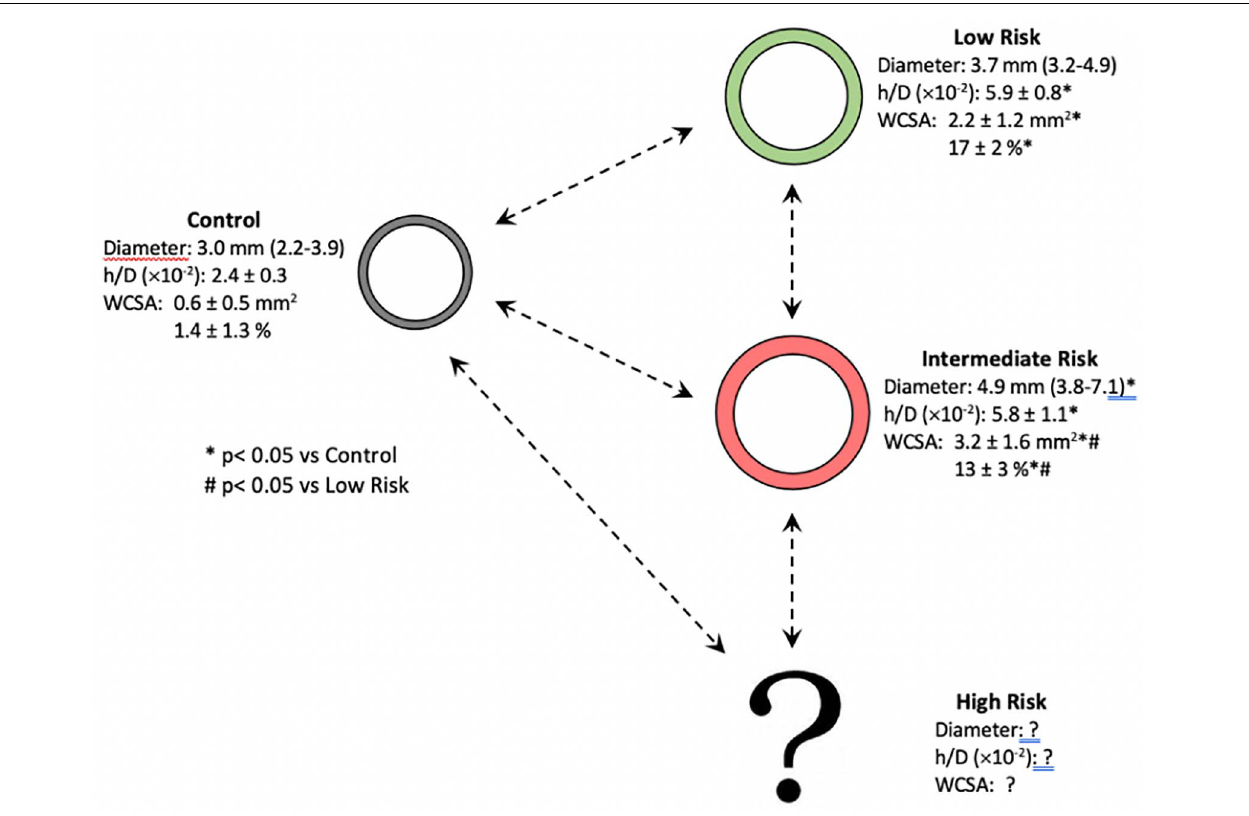
FIGURE 6 | Proposed progression of the pulmonary arterial remodeling according to the stratification risk on prevalent PAH patients. Compared with controls, we may speculate that pulmonary arteries of PAH subjects could show an outward hypertrophic remodeling given by significant enlargement of vessel diameter, increased h/D ratio, and WCSA. The possibility of pathways with different trajectories is highlighted (h/D, wall thickness/lumen diameter ratio; PAH, pulmonary arterial hypertension; WCSA, wall cross-sectional